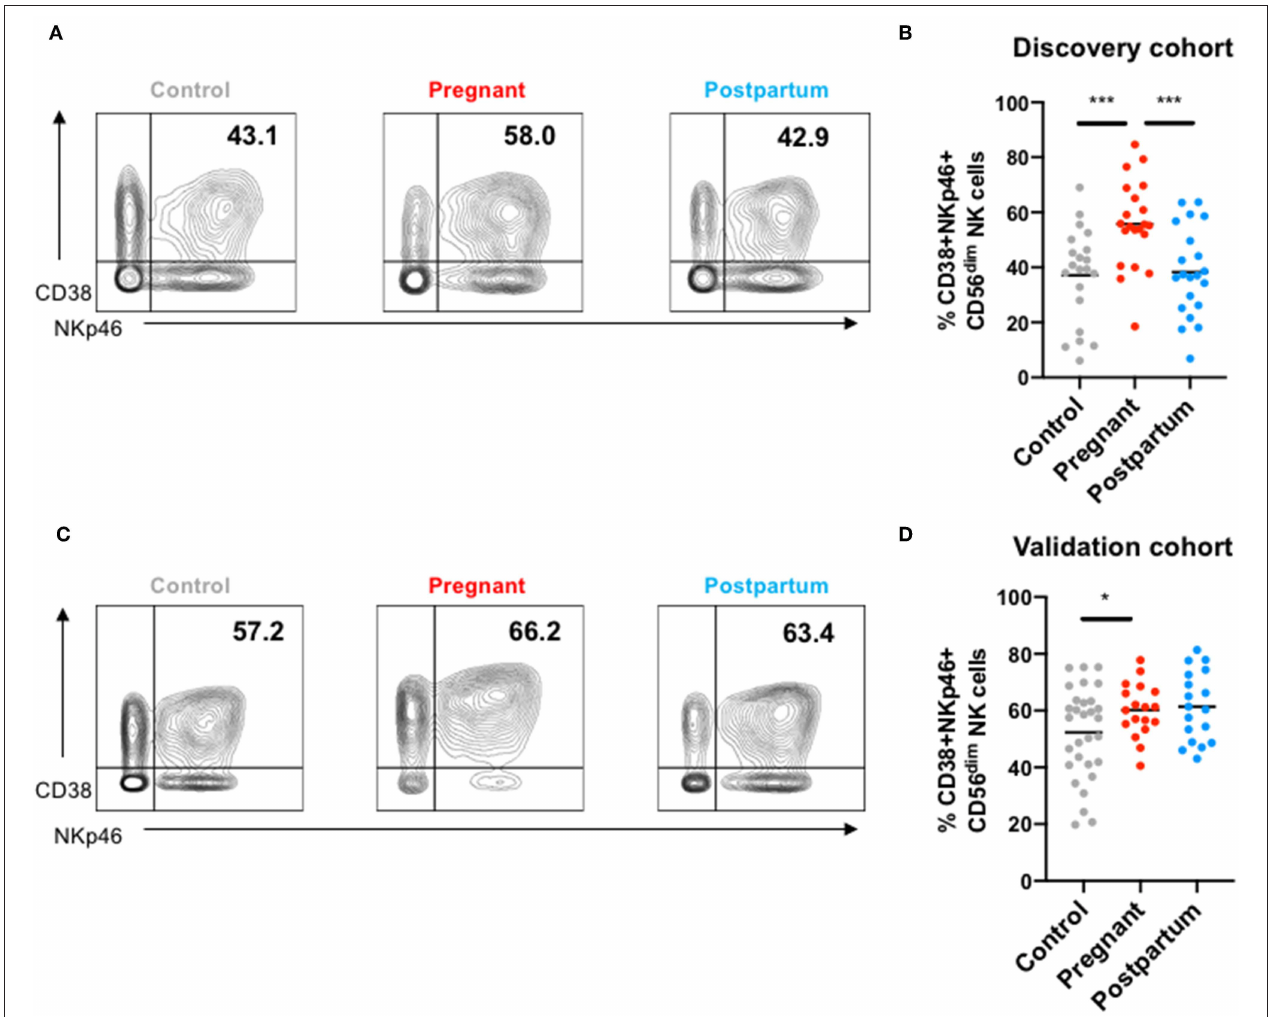
FIGURE 4 | NKp46 and CD38 co-expression in NK cells from controls, pregnant and post-partum women in the discovery and validation cohort. (A) Representative mass cytometry plots showing the co-expression of NKp46 and CD38 in peripheral NK cells from a control, pregnant or post-partum women in the discovery cohort. (B) Frequency of CD38 + NKp46 + NK cells from controls, pregnant and post-partum individuals in the discovery cohort. *** P < 0.001 (Mann–Whitney U -Tests to compare controls vs. pregnant; Wilcoxon matched-paired test to compare pregnant vs. post-partum). (C) Representative mass cytometry plots showing the co-expression of NKp46 and CD38 in peripheral NK cells from a control, pregnant, or post-partum women in the validation cohort. (D) Frequency of CD38 + NKp46 + NK cells from controls, pregnant and post-partum individuals in the validation cohort. * P < 0.05 (Mann–Whitney U -Tests to compare controls vs. pregnant; Wilcoxon matched-paired test to compare pregnant vs.